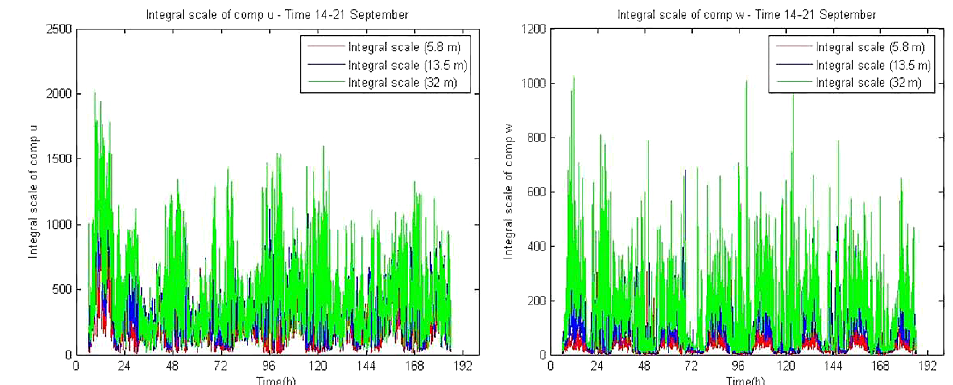
Figure 4. Variation of the integral length scale of horizontal and vertical components vs. time at the three heights.